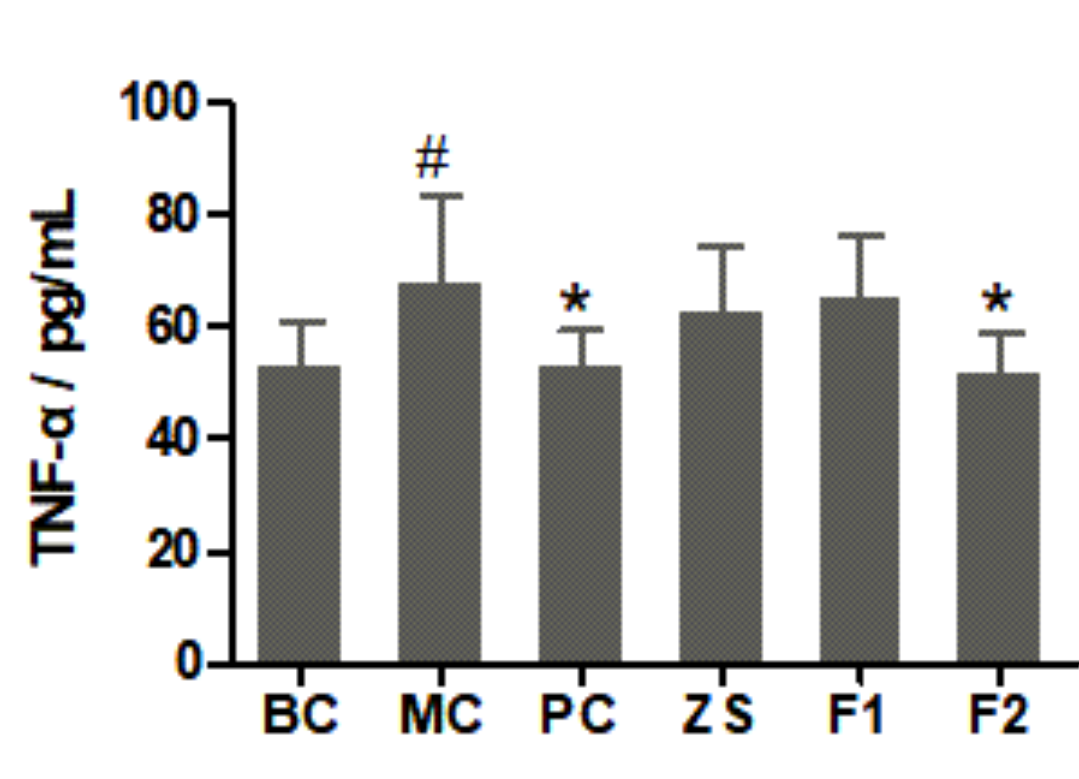
FIGURE 3 - Effect of BCLE on TNF- α of KK-A y mice (data are expressed as means ±